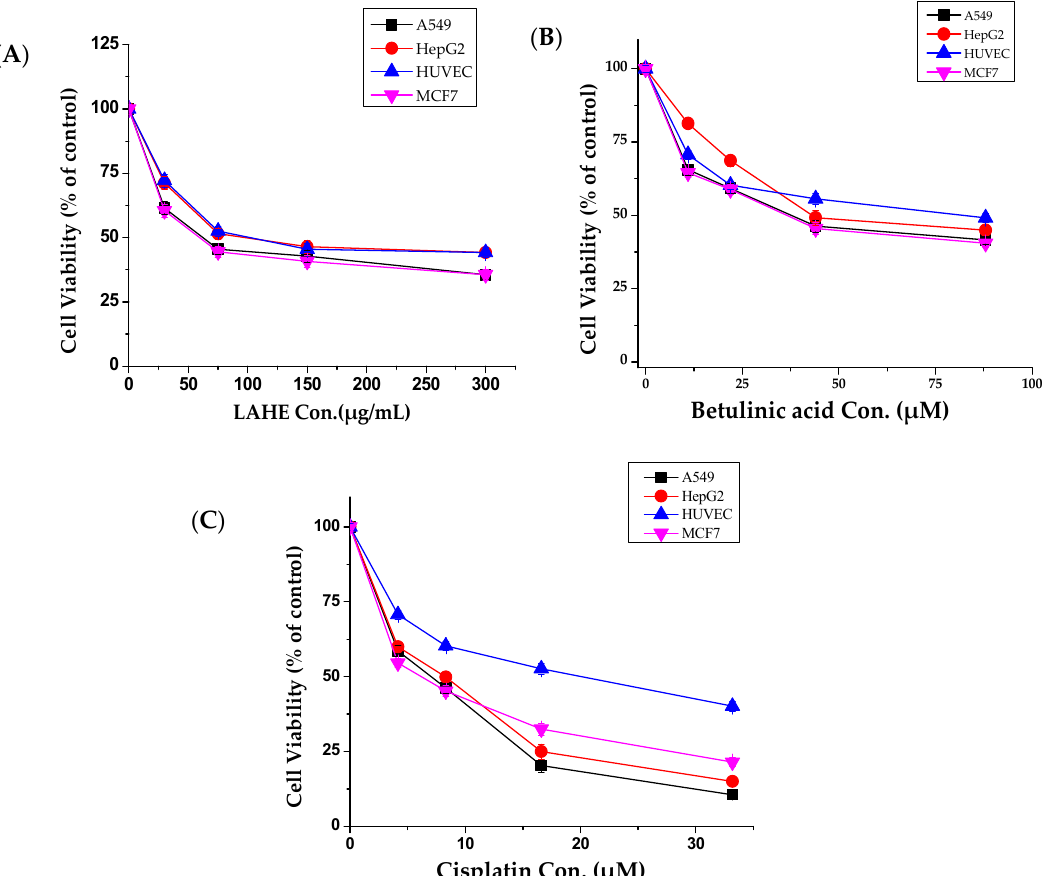
Figure 2. Tumor and normal cells dose-response curves for hexane fraction (LAHE) and betulinic acid. ( A ) Dose-dependent curves of n-hexane fraction, ( B ) Betulinic acid, and ( C ) Cisplatin (positive control). Cells were cultured in 24-well plates and treated with different concentrations (10–300 µg/mL) for 48 h. Cell viability was determined by MTT assay. Data were analyzed using Origin Pro 8 software. LAHE, L. acaciae n-hexane extract.